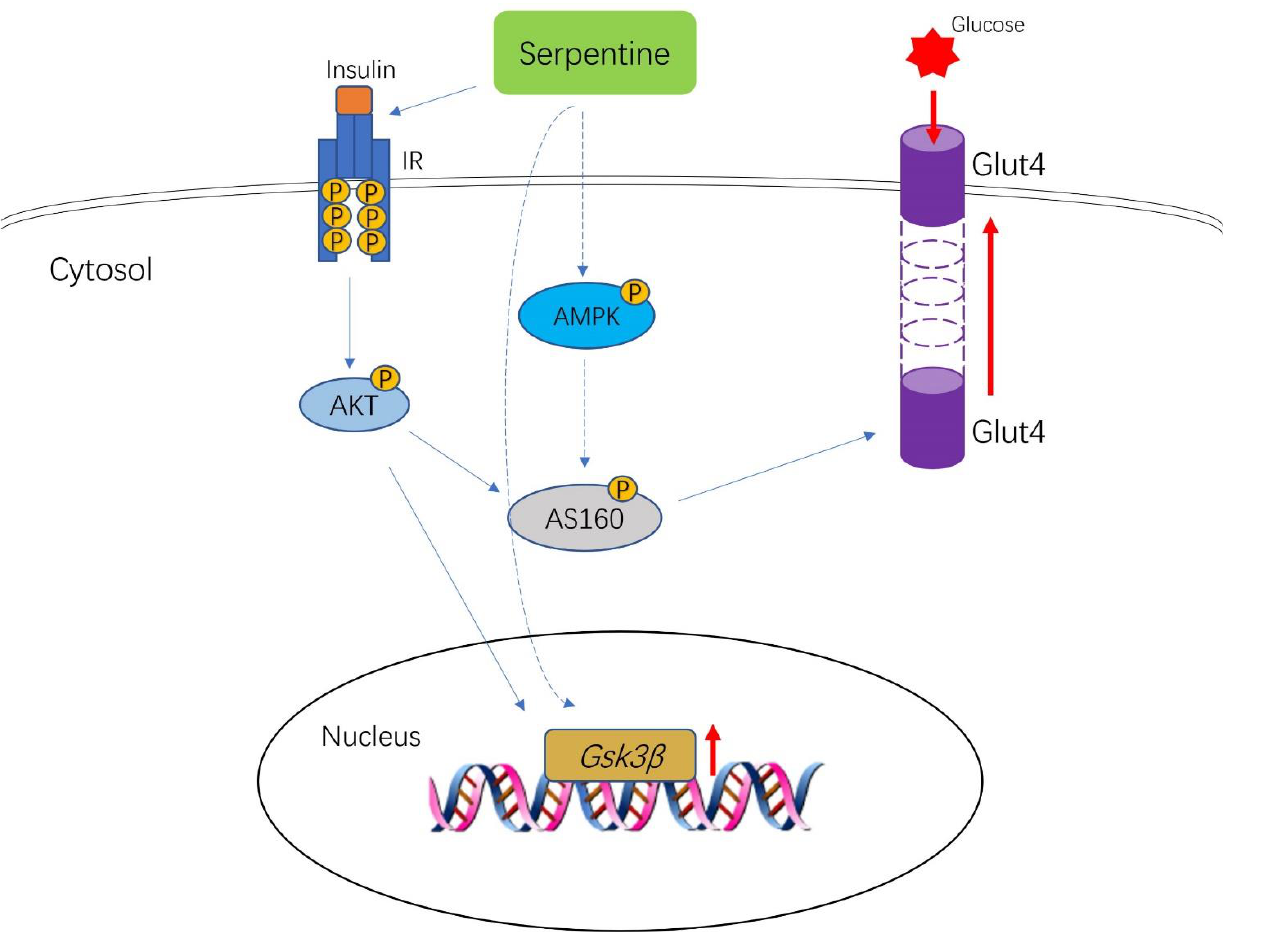
Figure 7. Serpentine acts as an insulin sensitizer to enhance its activation of the insulin signaling pathway through binding insulin receptor, improving glucose metabolism in C2C12 and 3T3-L1 cells and HFD/STZ-induced diabetic mice. Serpentine additionally activates AMPK-AS160-GLUT4 signaling, in turn, enhancing GLUT4 membrane transfer and improving glucose metabolism in C2C12 cells.